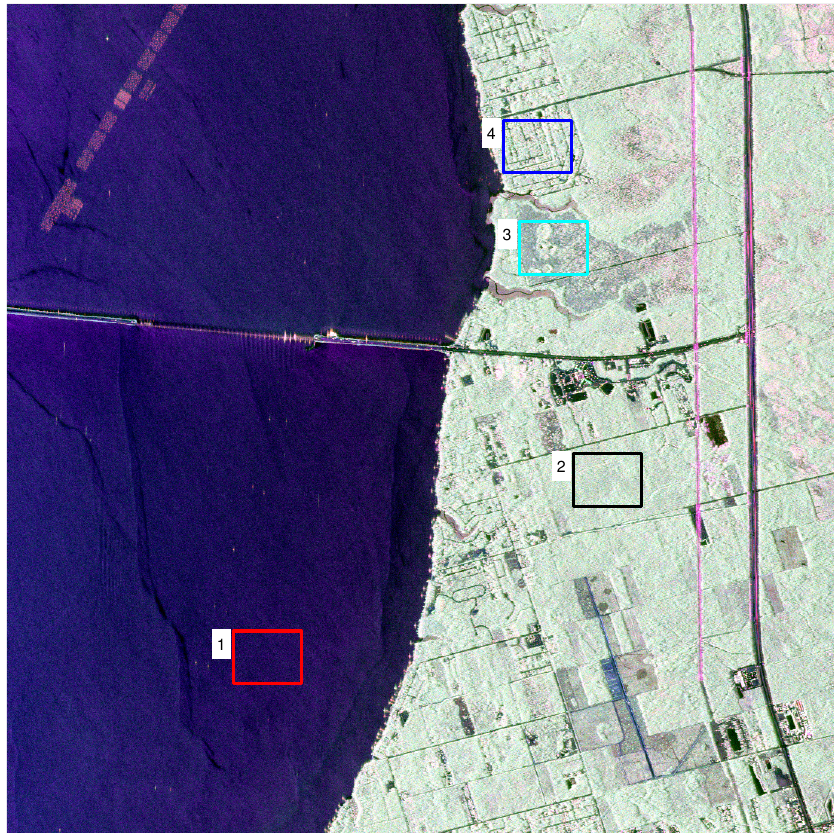
Figure 5. Test regions on the UAVSAR data. Four ROIs over different land types are tested, including the sea, the forest, the wetland and the urban